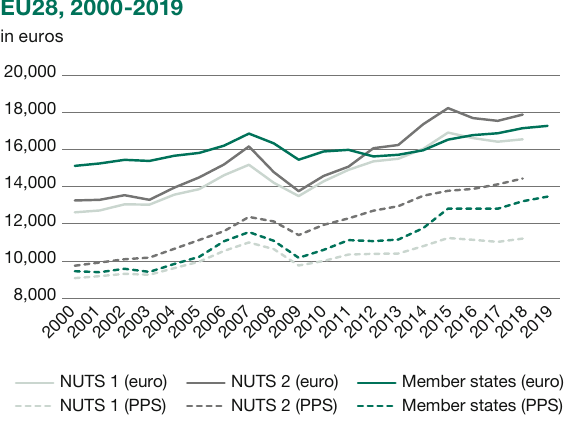
Figure 2 Coeffi cient of variation of per capita incomes in the EU28, 2000-2019